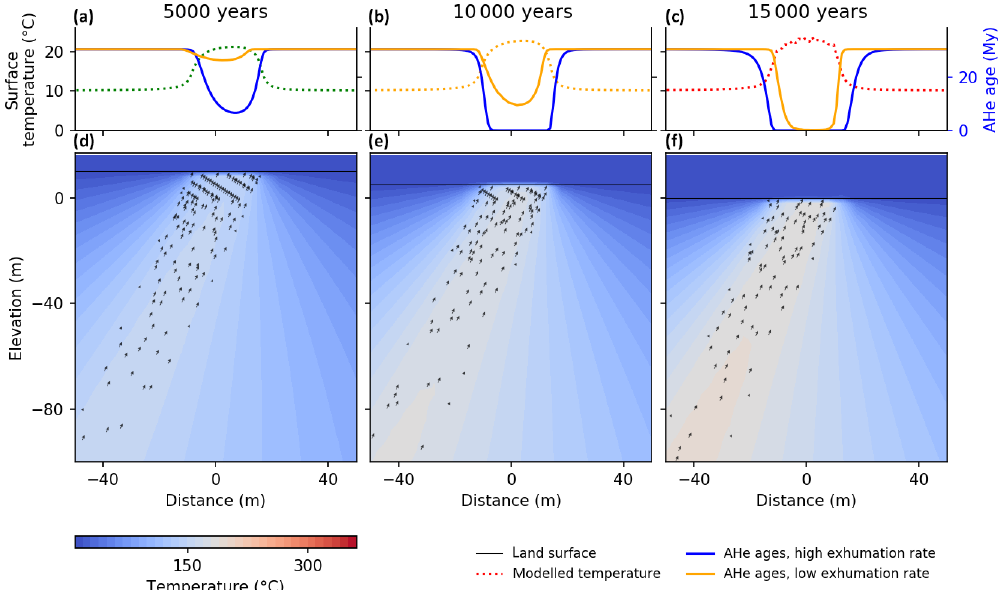
Figure 7. Modelled surface and subsurface temperatures and AHe ages for three time slices for a model run with a high exhumation rate (1 × 10 − 3 ma − 1 ) and a low exhumation rate (1 × 10 − 4 ma − 1 ). Panels (a) , (b) and (c) show the modelled temperature at the land surface and modelled AHe ages for surface samples. Panels (d) , (e) and (f) show the modelled temperature field in response to upward advective flux along a fault for the model run with a high exhumation rate.